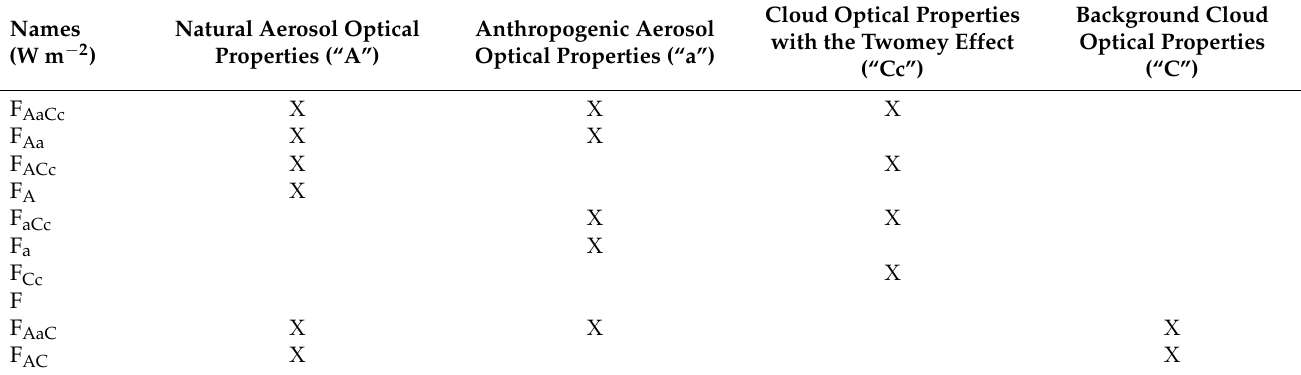
Table 1. Different shortwave net radiative fluxes at the top-of-the-atmosphere